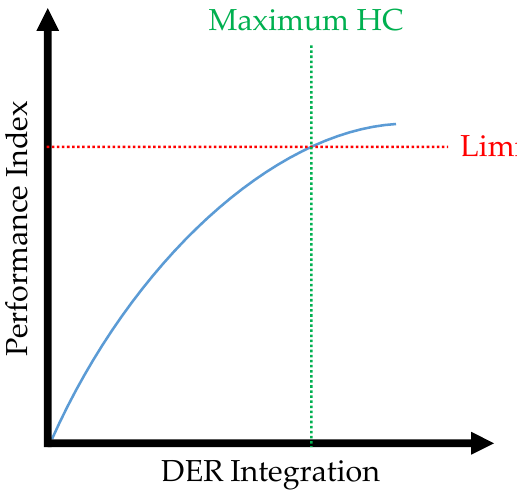
Figure 1. The concept of hosting capacity.